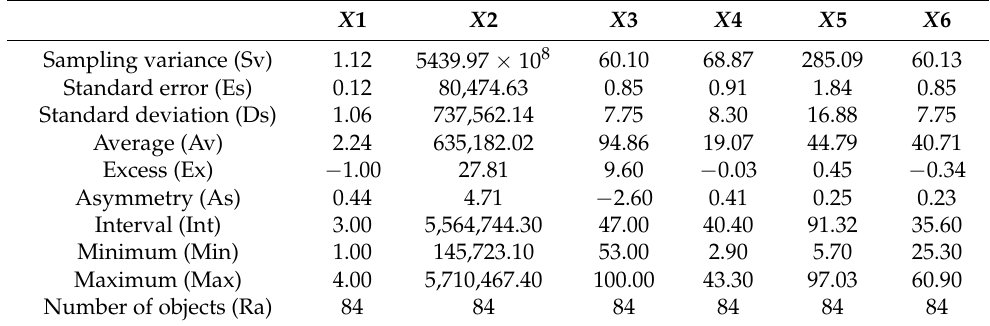
Table 1. Descriptive data statistics for intelligent analysis of the probability of creating an integration platform in sociotechnical